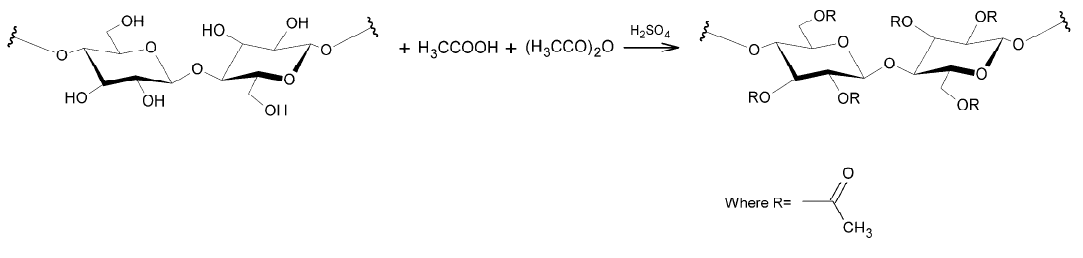
Figure 1. Scheme of acetylation of cellulose.